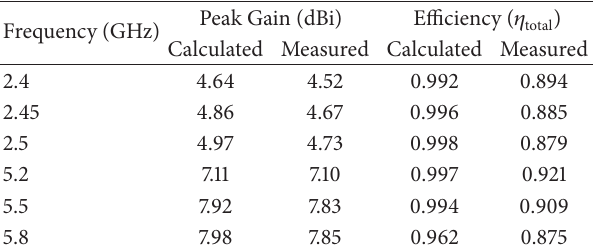
Table 2: Comparison of peak gain and antenna